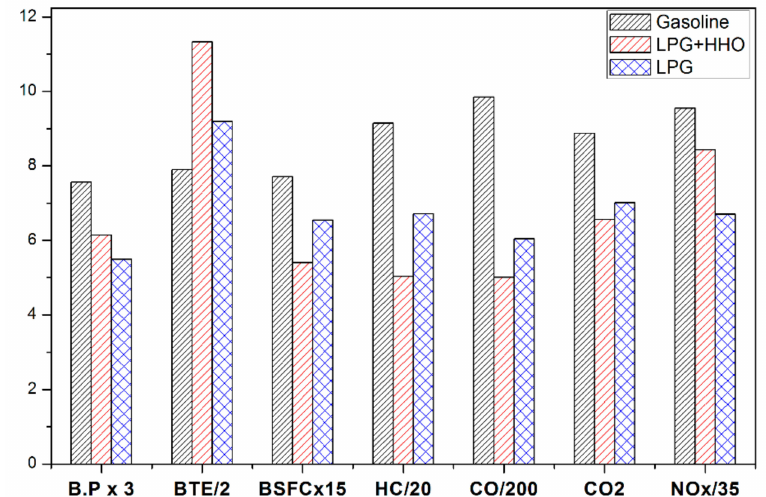
Figure 10. Graphical summary of the operational and emission parameters for gasoline, LPG and LPG-HHO